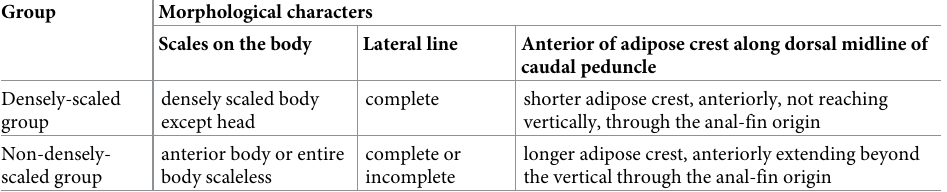
Table 1. Comparison of characters between the densely-scaled and non-densely-scaled groups of Homatula (Li, Che & Zhou, 2019).